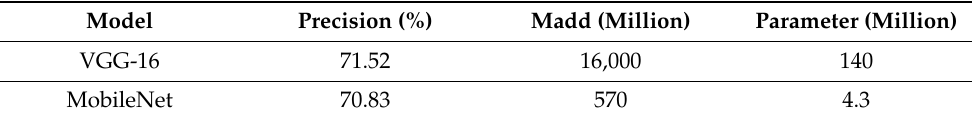
Table 1. Comparison results of MobileNet and VGG-16 on ImageNet.